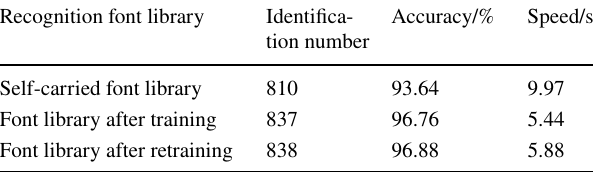
Table 6 Character recognition results of different fonts Recognition font